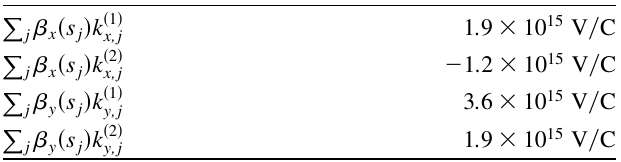
TABLE IV. Products of the kick factors and the betatron functions estimated from the measured tune shifts.